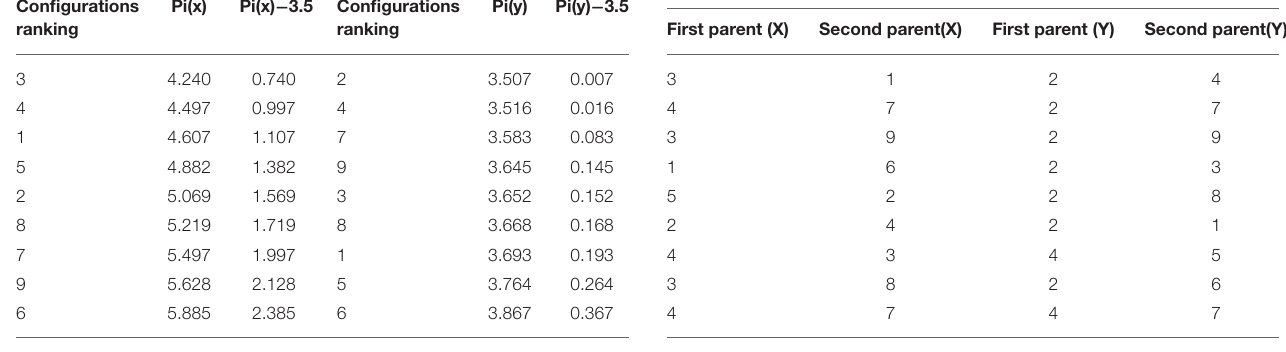
TABLE 4 | Parental choosing in X and Y direction. Configurations rank X